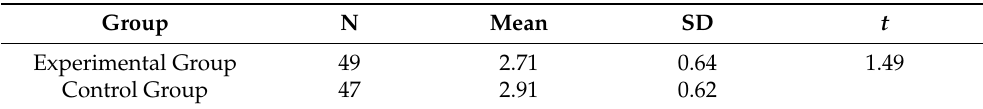
Table 3. The t -test results of students’ cognitive load.